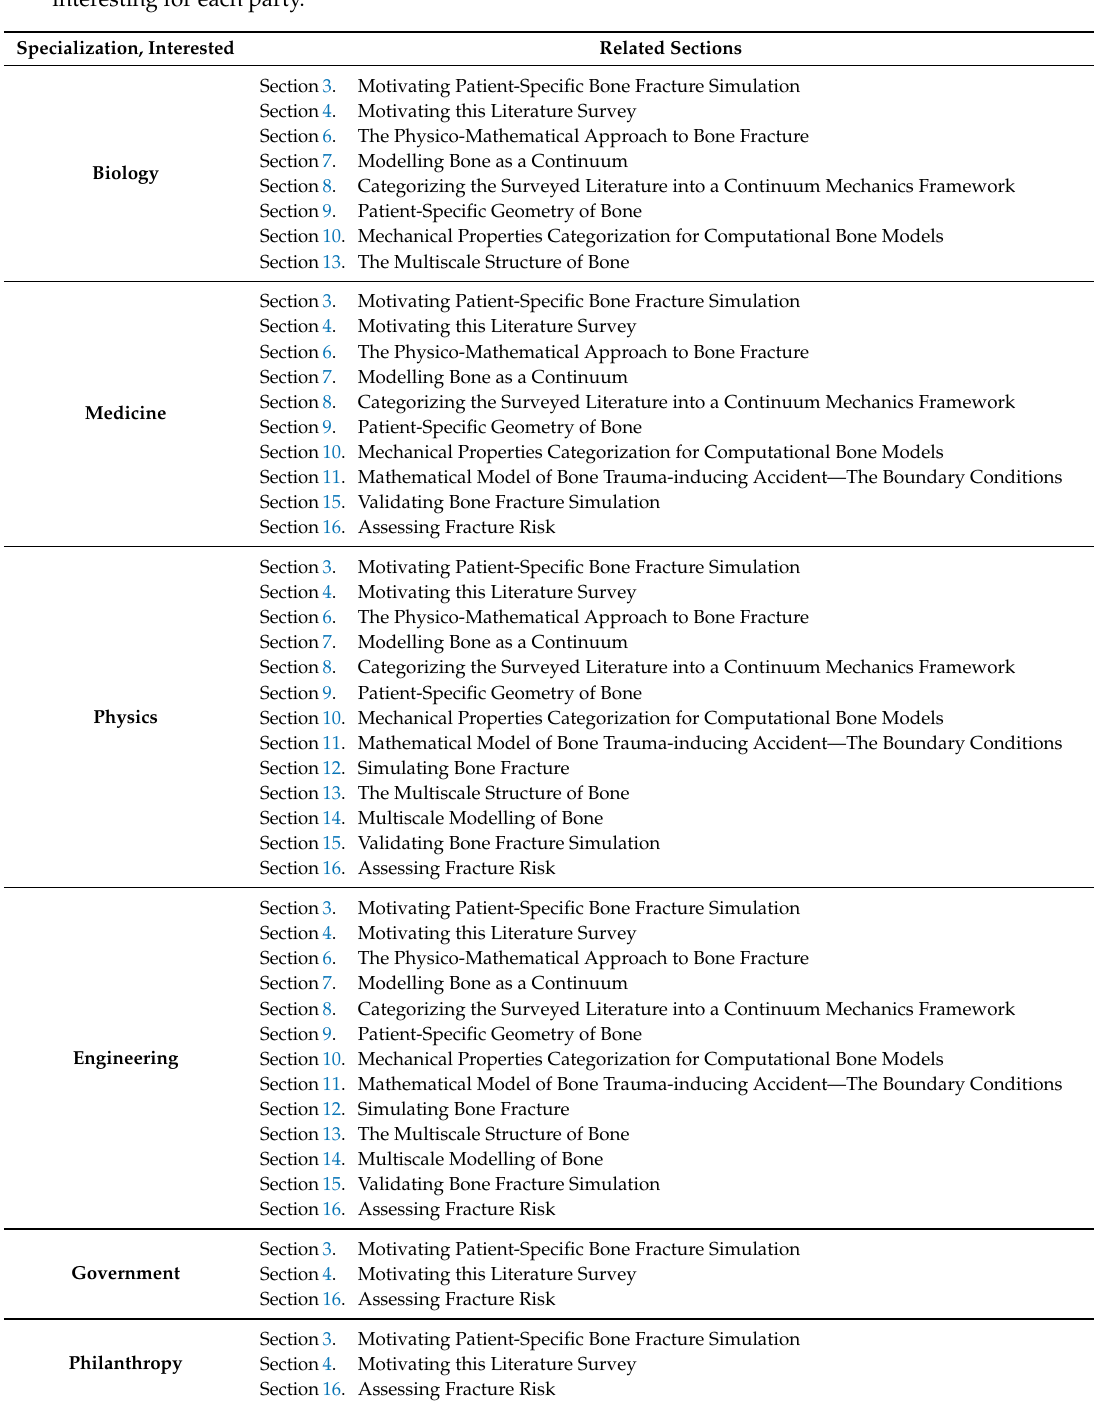
interesting for each